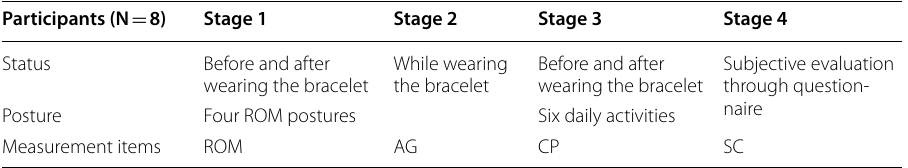
ROM range of motion, AG air gap, CP clothing pressure, SC subjective comfort